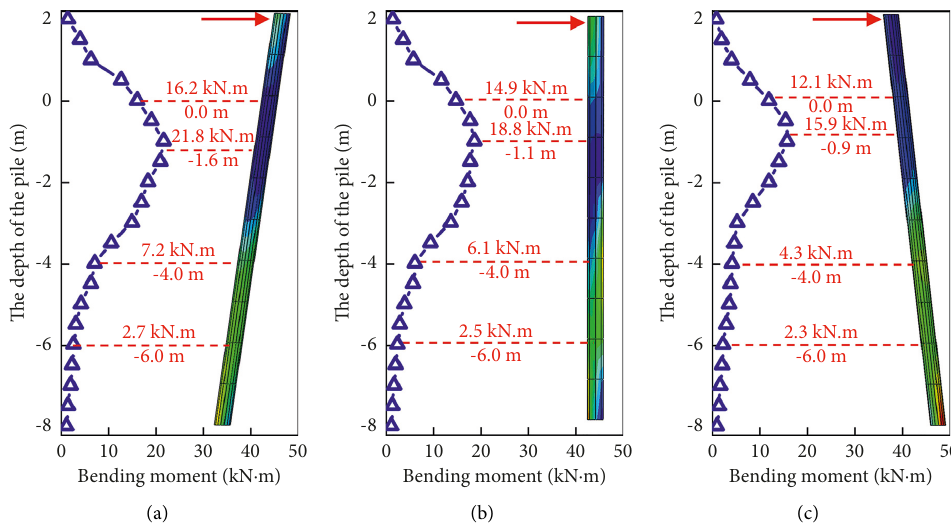
Figure 9: Pile bending moment comparison diagram: (a) bending moment of positive inclined pile; (b) bending moment of vertical pile; (c) bending moment of negative inclined pile.